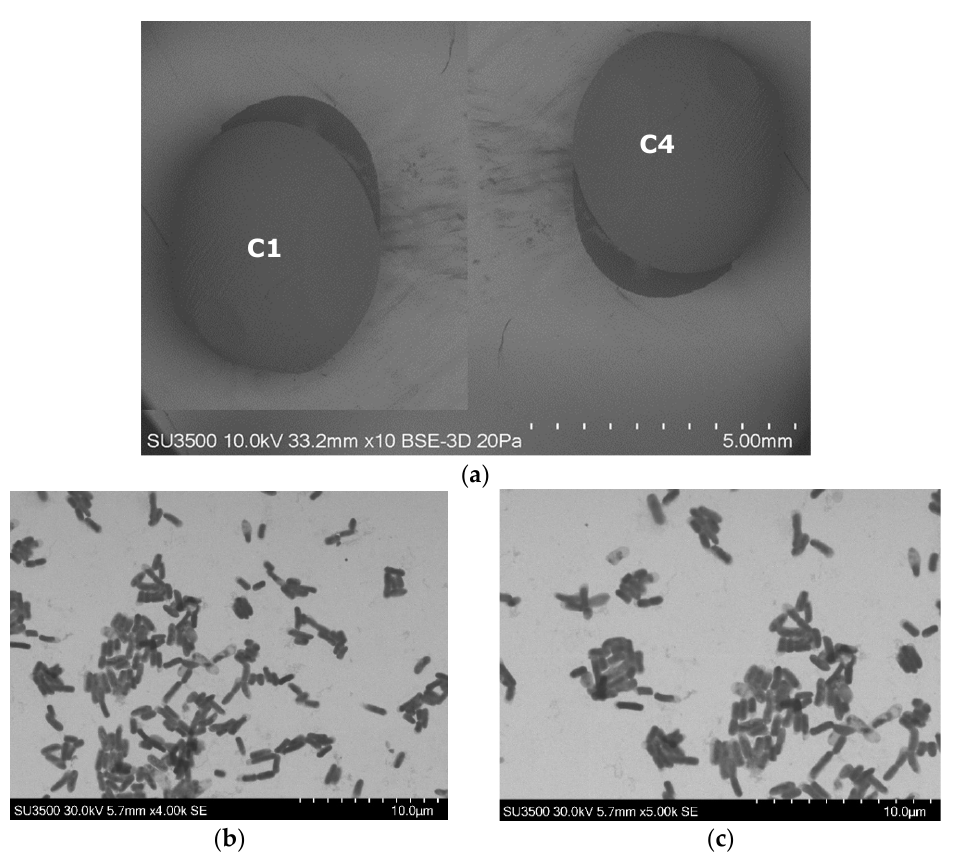
Figure 3. Electron scan micrographs of alginate beads with bacterial strains A. spanius C1 and P. rhodesiae C4 immobilized individually; ( a ) morphological surfaces of alginate beads (strains C1 and C4); ( b ) inside view of alginate bead with strain C1; ( c ) inside view of alginate bead with strain C4.